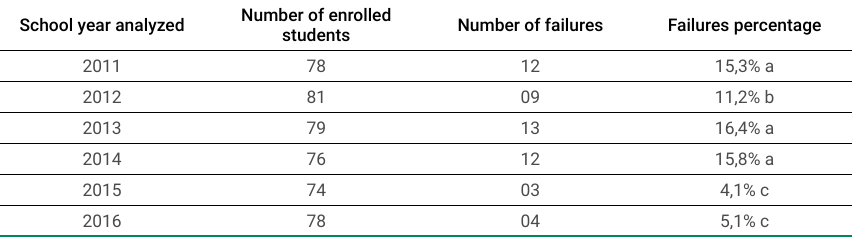
Table 1. Percentage of students’ disapprovals of the Integral period in the discipline of Pharmacology of FOA / UNESP, according to the school year analyzed Number of enrolled School year analyzed students